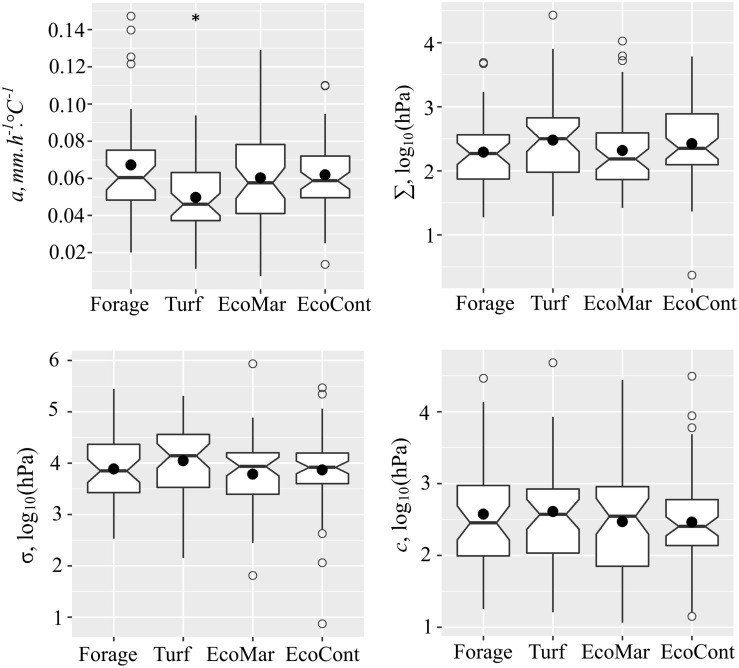
Variation of thermal leaf growth (a), leaf growth reduction point (Σ), leaf growth arrest point (σ), and water deprivation tolerance (c) between the forage cultivar (n = 43), turf cultivar (n = 46), maritime origin ecotype (EcoMar, n = 50) and continental origin ecotype (EcoCont, n = 58) groups in the perennial ryegrass panel. *indicates significant difference at P < 0.05 (Student’s t-test).